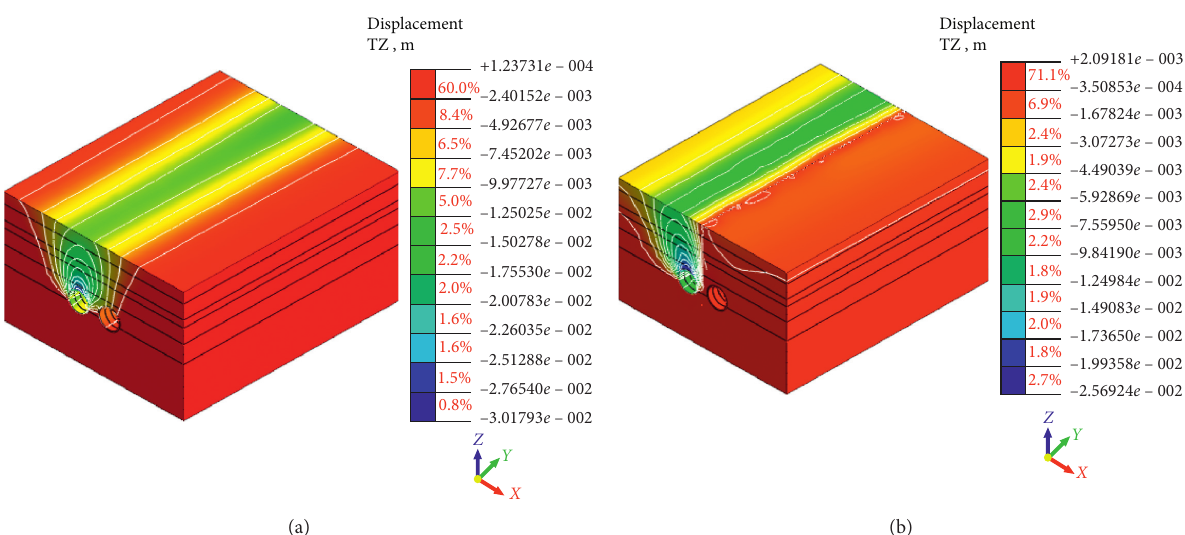
Figure 10: Stratum settlement nephogram before and after reinforcement. (a) Nephogram of unreinforced stratum settlement; (b) nephogram of stratum settlement after